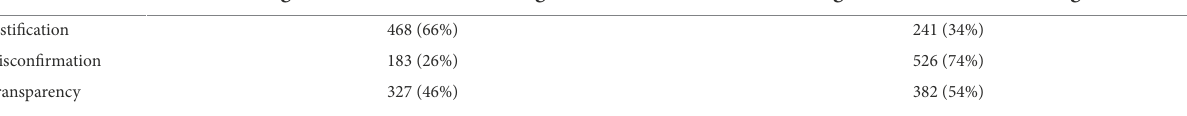
TABLE 1 Prevalence of the individual facets justification, disconfirmation, and transparency in the 709 diagnostic argumentation texts. Number of argumentation texts including the facet